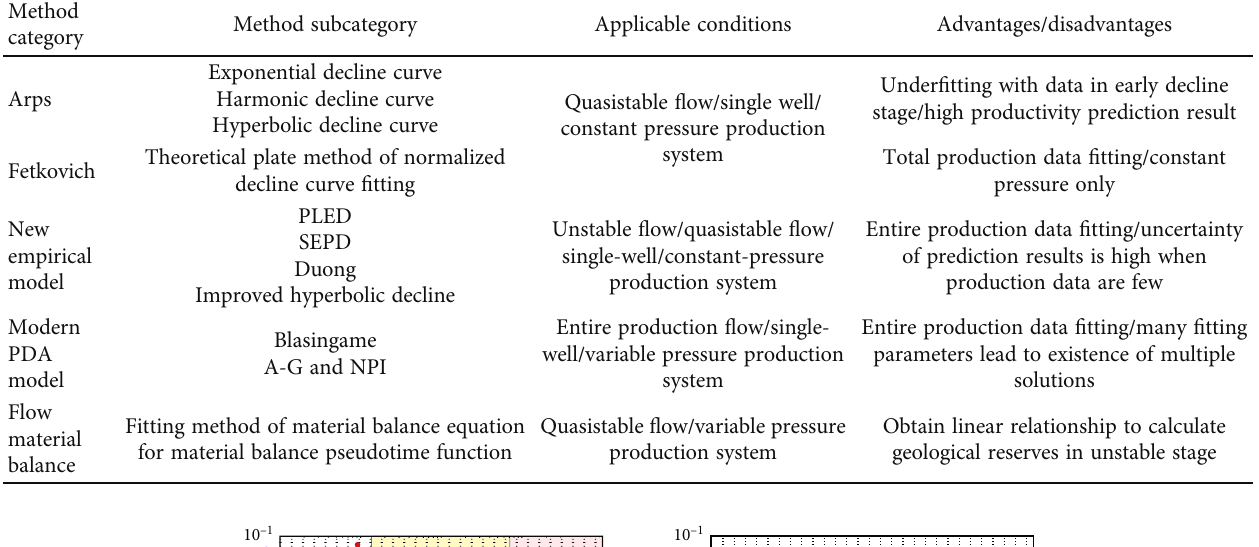
Table 1: Summary of production decline analysis methods.